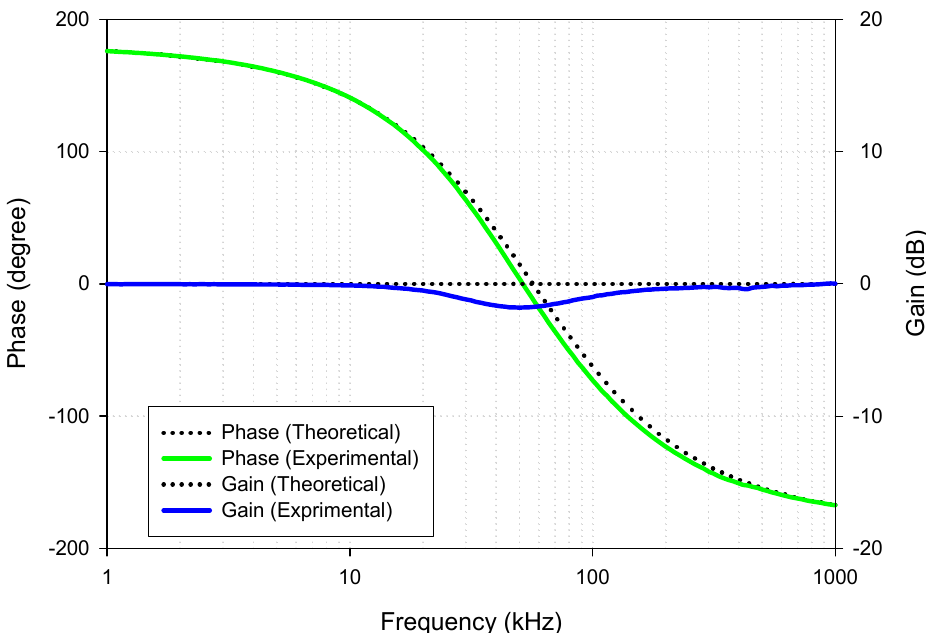
Figure 24. Experimental gain and phase response of the AP filer ( I B1 = I B2 = 200µA, R 1 = 1 k and C 1 = C 2 = 5.5 nF).